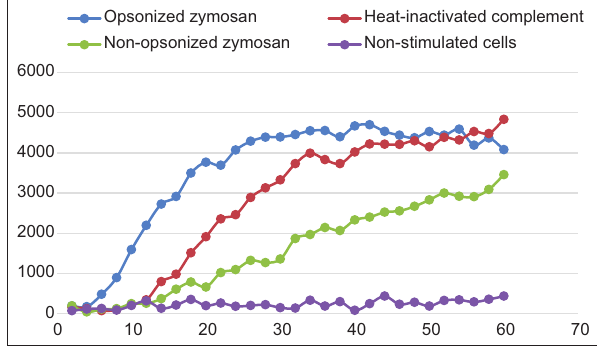
Figure-3: Comparison of luminol-dependent chemilumine scence responses of camel peripheral blood leukocytes with opsonized zymosan, zymosan opsonized with heat-inactivated serum, non-opsonized zymosan, and non-stimulated cells.